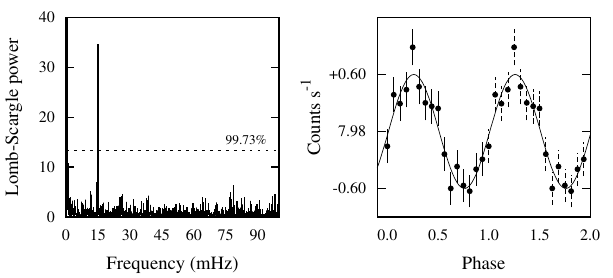
Figure 1: Lomb-Scargle periodogram (left) and folded light curve (right) of CAL 83 XMM-Newton dataset 0506531501 PN. Both the periodogram and folded light curve display a significant 66.8 s oscillation.